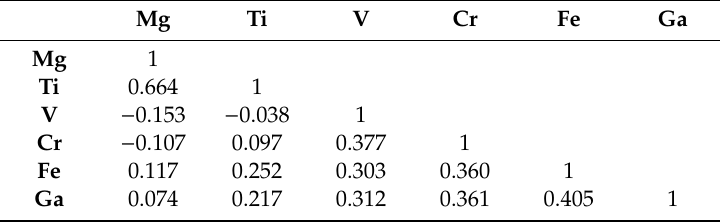
Figure 5. Trace element plots of secondary Montana blue and pink sapphires and rubies showing characteristic ranges of their trace elements.